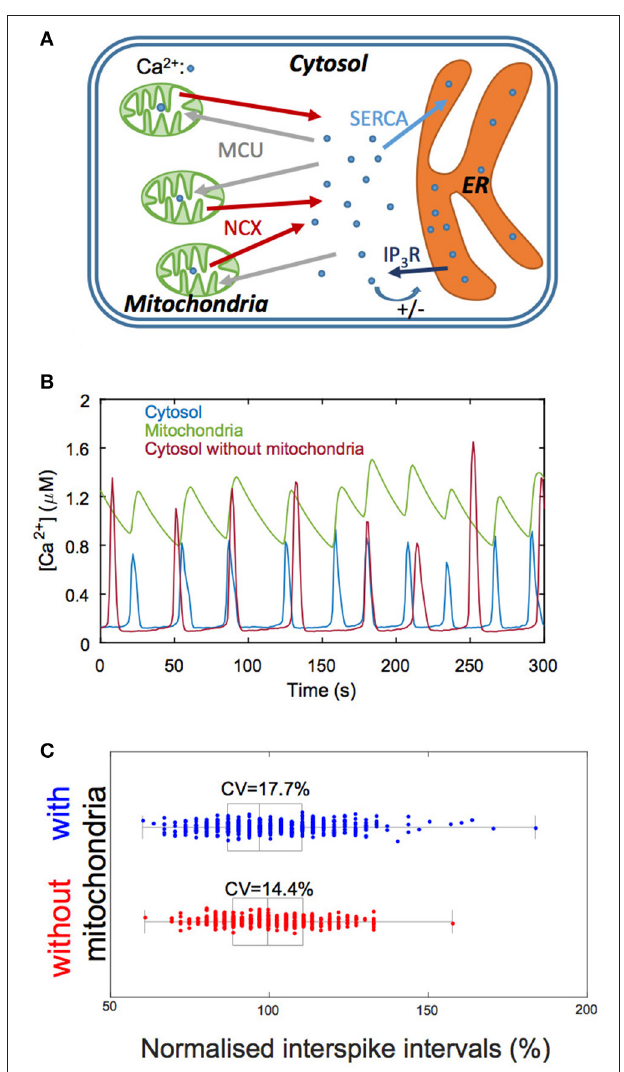
FIGURE 4 | Involvement of mitochondrial Ca 2 + fluxes in simulations of Ca 2 + oscillations. (A) Schematic representation of the Ca 2 + exchanges processes between the three main cellular Ca 2 + compartments: the cytosol, the mitochondria and the endoplasmic reticulum (ER). IP 3 R: IP 3 receptor; MCU: mitochondrial Ca 2 + uniporter; NCX: Na + /Ca 2 + exchanger; SERCA: sarco- or endoplasmic reticulum Ca 2 + ATPase. (B) Numerical simulations of Ca 2